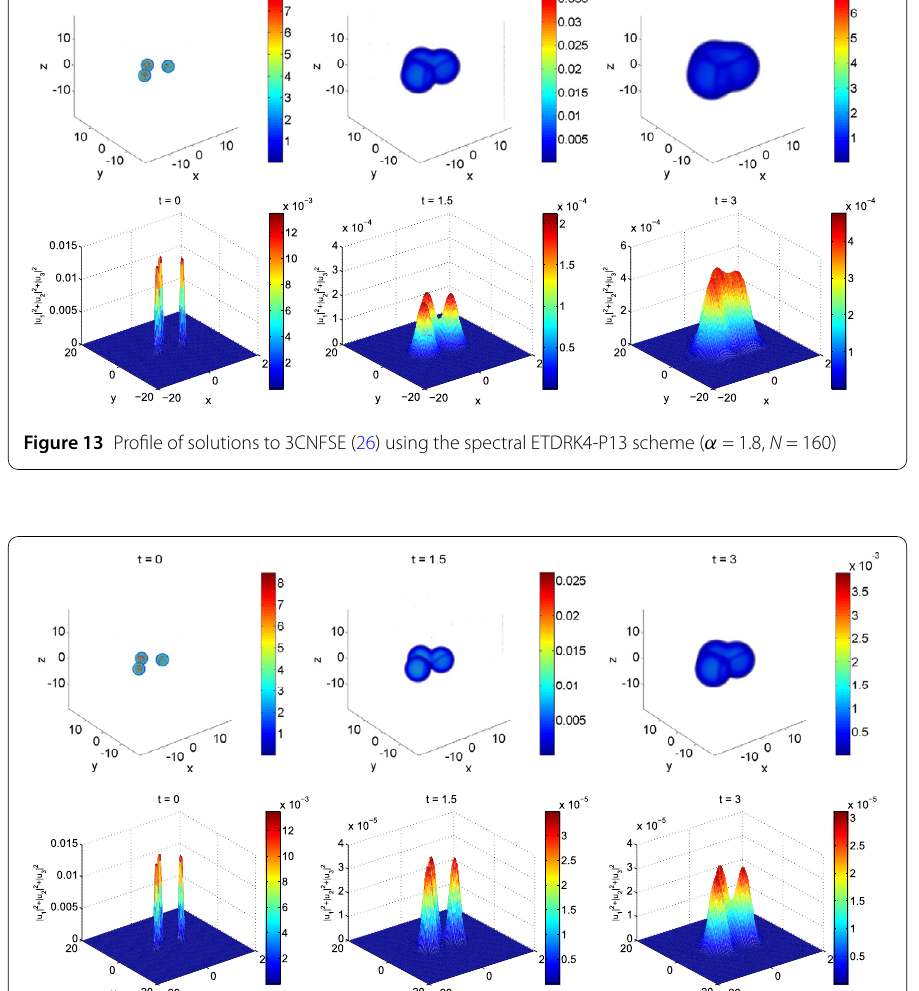
with γ = 1, ρ = 1, d = 5, B 1 = B 2 = B 3 = 20, Ω = [–20,20] 3 , T = 3, and periodic boundary conditions on ∂Ω